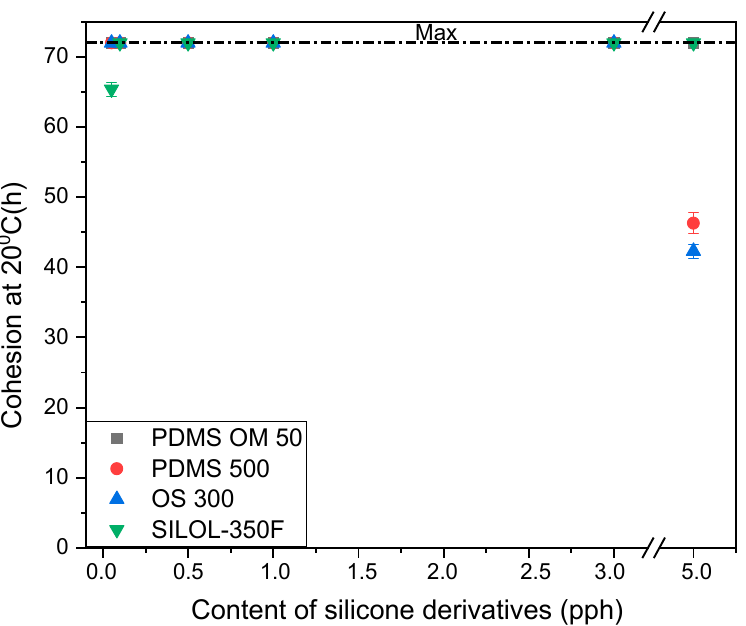
Figure 2. Effect of silicone derivatives addition on the cohesion at 20 °C of silicone pressure sensitive adhesives.